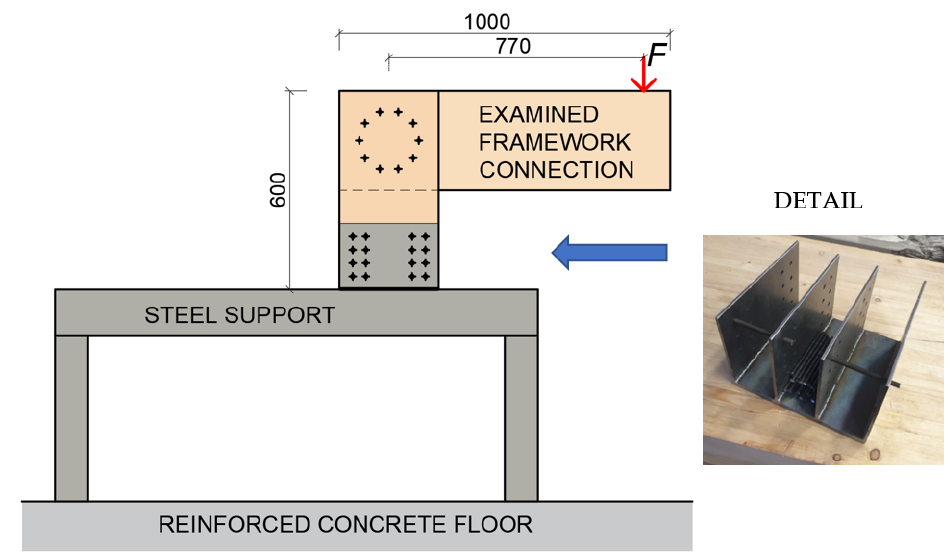
Figure 9. Schematic of the experiment and support detail.